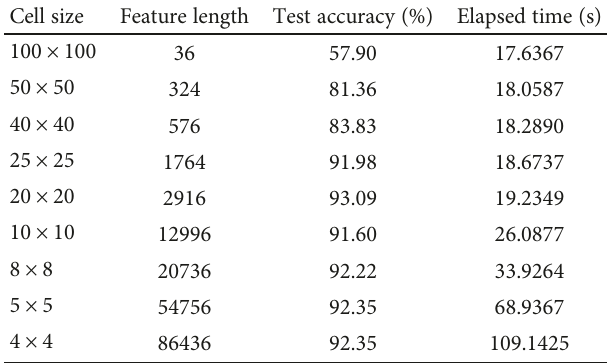
Table 3: SVM classi fi cation results using di ff erent cell sizes.